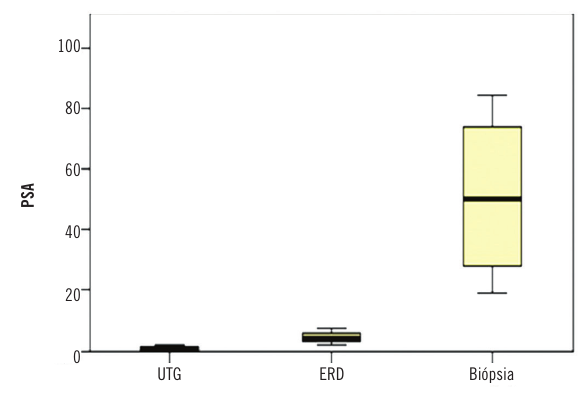
FIGuRA 3 – Diagrama de extremos e quartis da distribuição da variável sérica PSA em cada grupo de pacientes submetidos a exames anteriores PSA: antígeno prostático específico; UTG: ultrassonografia transretal guiada; ERD: exame retal digital da próstata.